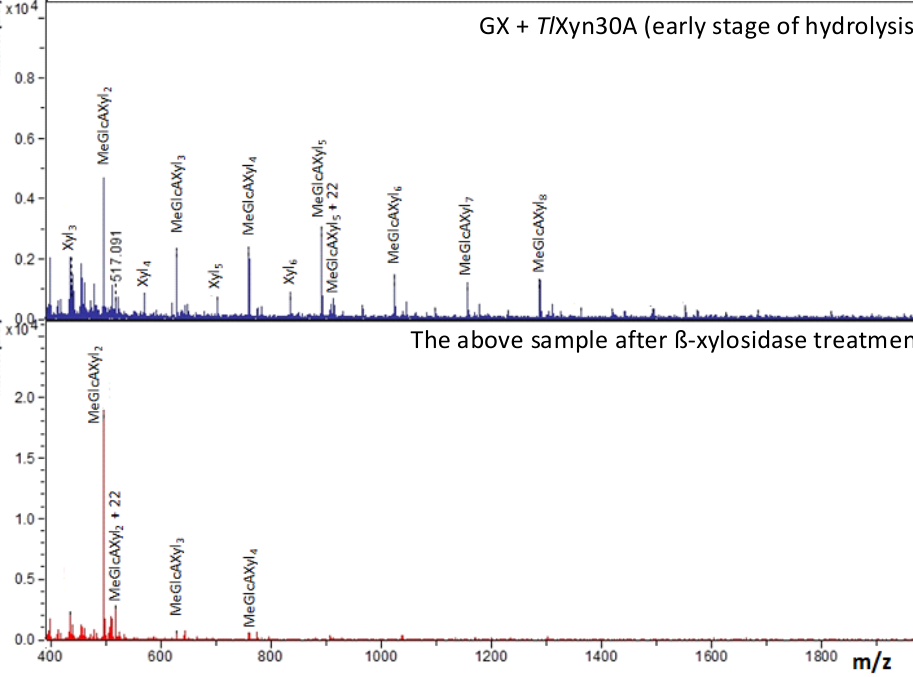
Figure 2. MALDI-ToF MS analysis of early stage reaction products of glucuronoxylan hydrolysis by Tl Xyn30A xylanase (upper spectrum), and their conversion to aldotriouronic acid MeGlcA 2 Xyl 2 accompanied with a disappearance of all linear xylooligosaccharides upon incubation with β -xylosidase (lower spectrum). Prior to addition of β -xylosidase, the Tl Xyn30A was thermally denatured. The peaks correspond to sodium adducts of the products. The signals of aldouronic acids are accompanied by ions of their sodium salts (indicated once in each spectrum), which are heavier by an m / z value of 22.